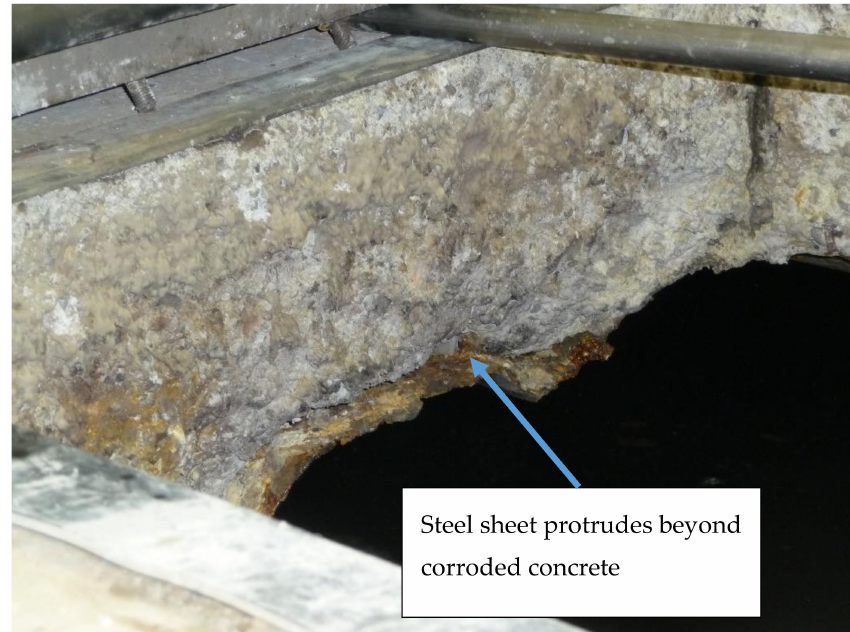
Figure 2. The folded sheet corroded more slowly than the concrete. Approximately 20 mm of sheet protrudes beyond the concrete. When built, concrete and steel were on one plane.